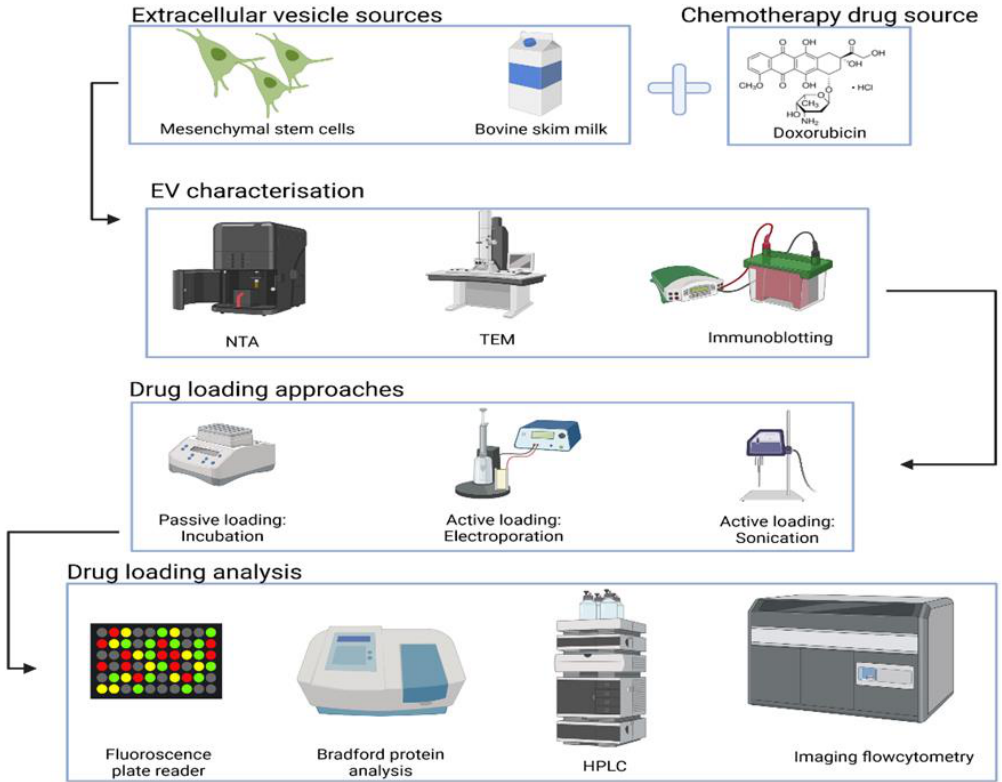
Figure 1. Illustrative summary of this comparative study. EVs were separated from MSCs and milk, characterised, and loaded with Dox by either passive loading (incubation) or active loading (electroporation or sonication). Both Dox loading successes and potential negative effects of loading on EVs (assessed for total protein as a surrogate and for established EVs surface proteins) were evaluated.